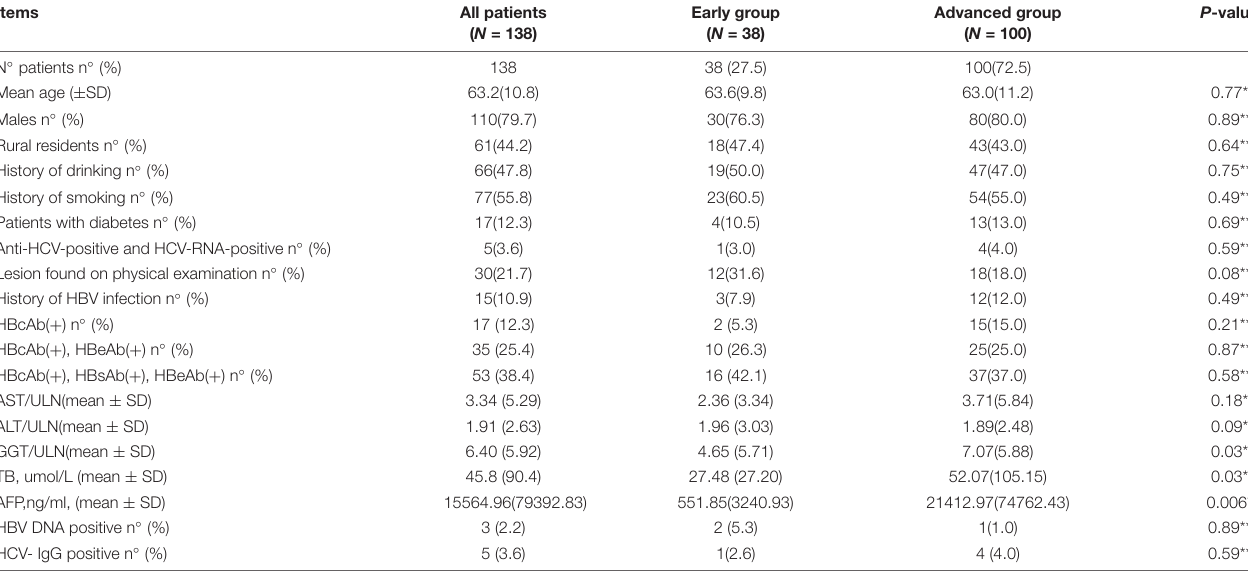
TABLE 2 | Comparison of some characteristics of early and advanced hepatocellular.